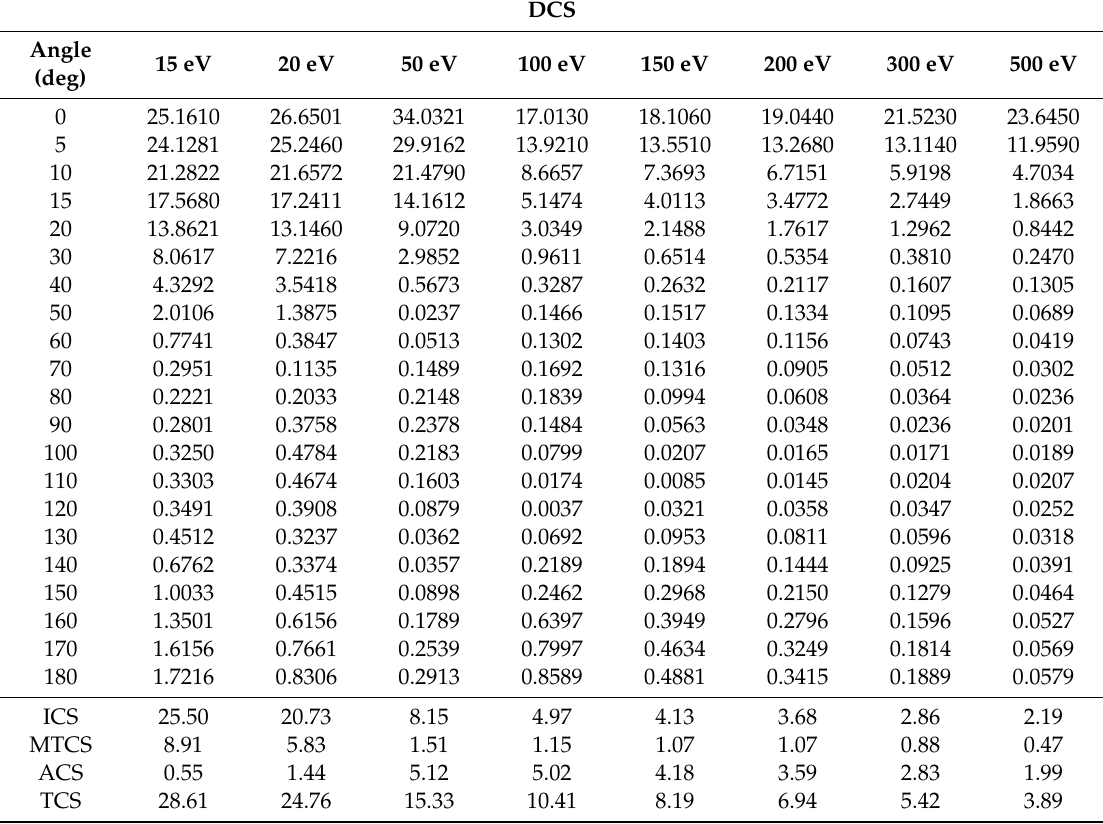
Table 3. Cross sections for electron-H 2 S scattering. The DCS is in units of 10 − 16 cm 2 /sr and ICS, MTCS, ACS and TCS are in units of 10 − 16 cm 2